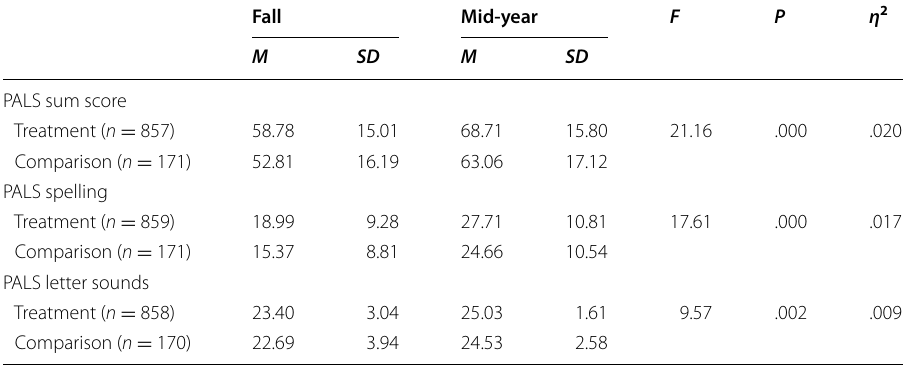
Table 2 Means, standard deviations, and analysis of variance for the effects of Pre-K